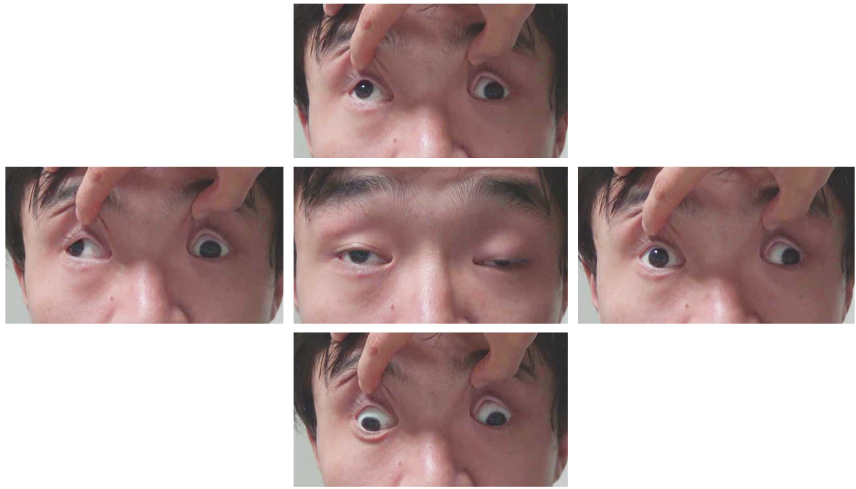
Figure 6: The patient from Figure 5 showing the ptosis and extraocular muscle